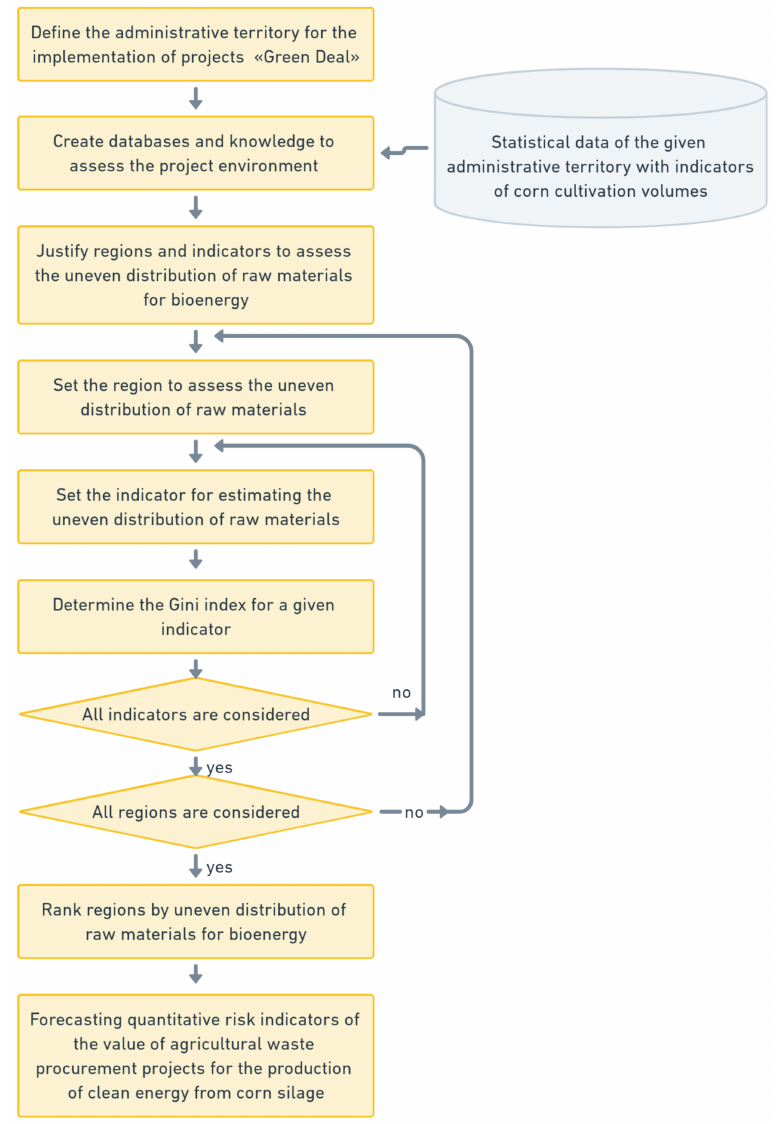
Figure 1. Block diagram of the algorithm for assessing the state of the project environment for the implementation in technologically integrated projects of the “European Green Deal” using maize